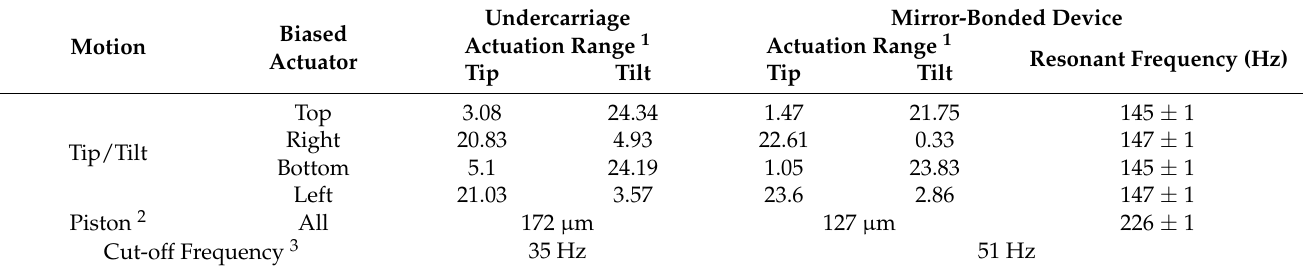
Table 4. Experimental Results summary for the undercarriage and the mirror-bonded